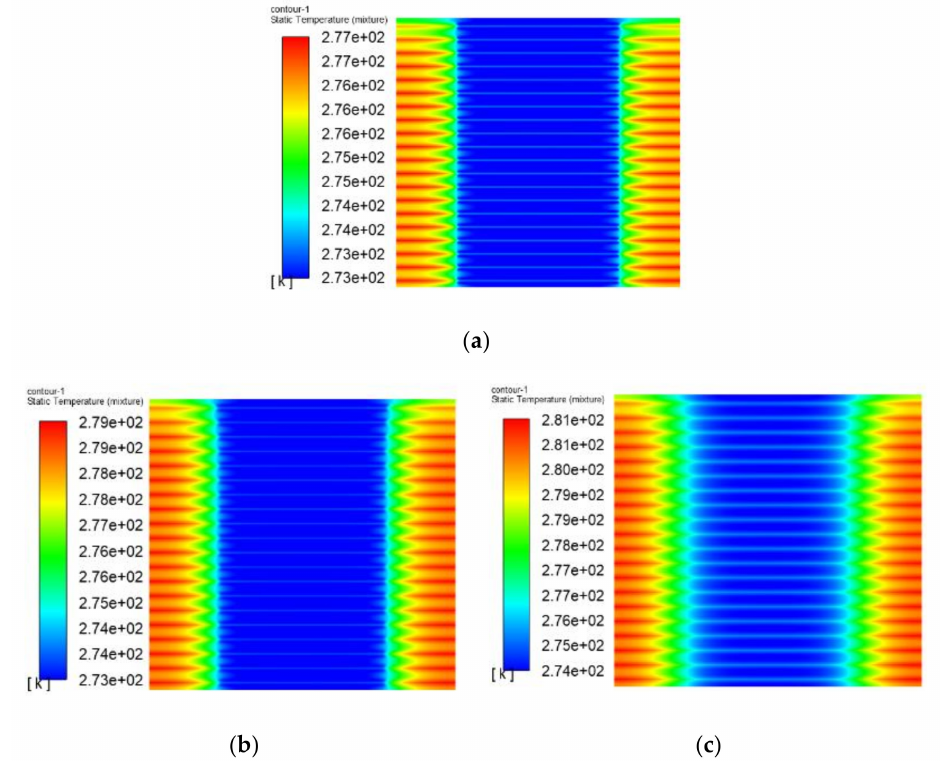
Figure 9. Temperature contours of the PEMFC stack at di ff erent times: ( a ) t = 24 s, ( b ) t = 28 s, ( c ) t = 32 s.